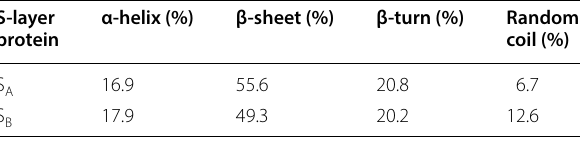
Table 1 The amount of secondary structure of the two S-layer proteins